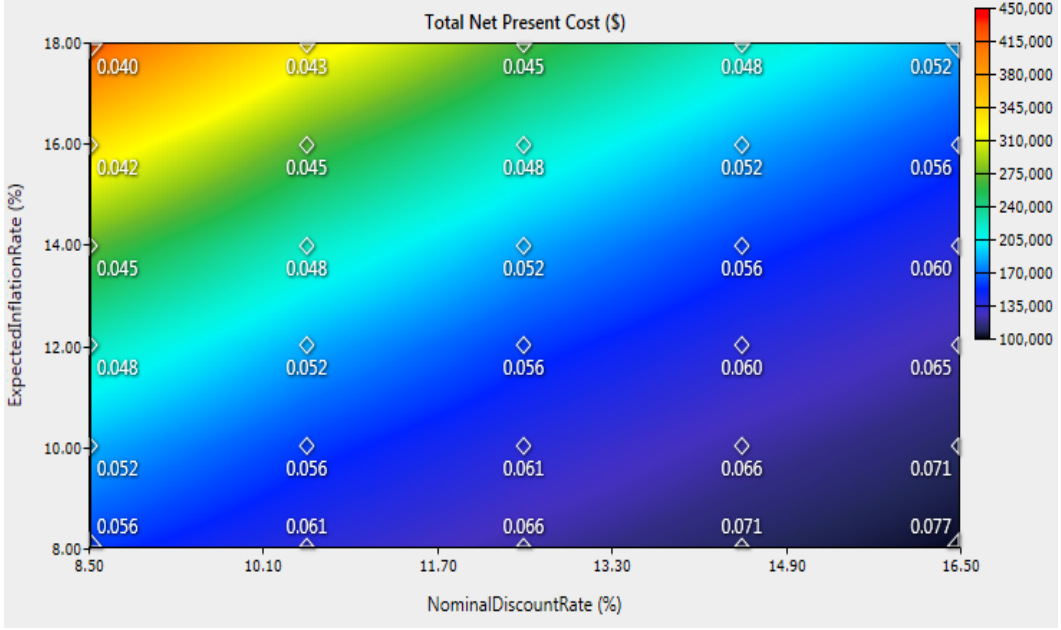
Figure 12. Impact of the nominal discount rate and inflation rate on the NPC and COE for the study site.